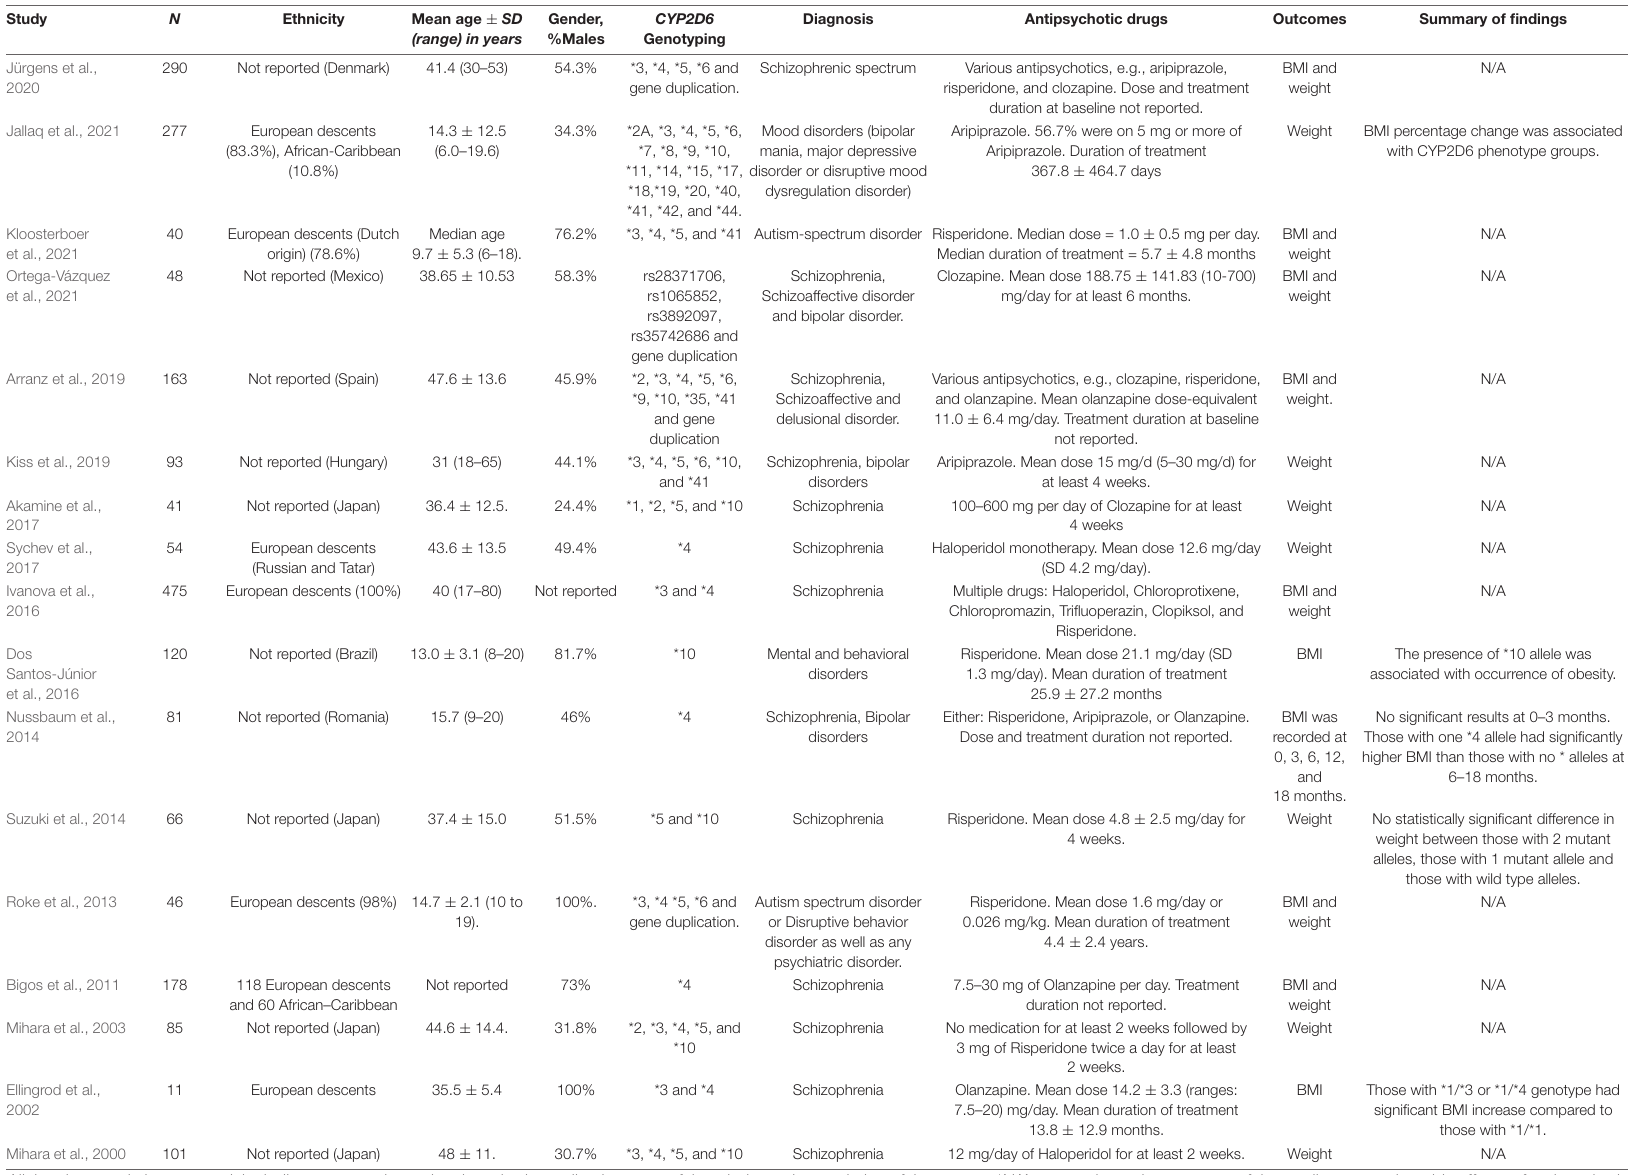
TABLE 3 | Characteristics of the studies included in the